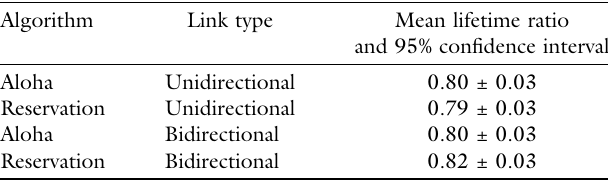
Table 3. Link lifetime results from experimental data.